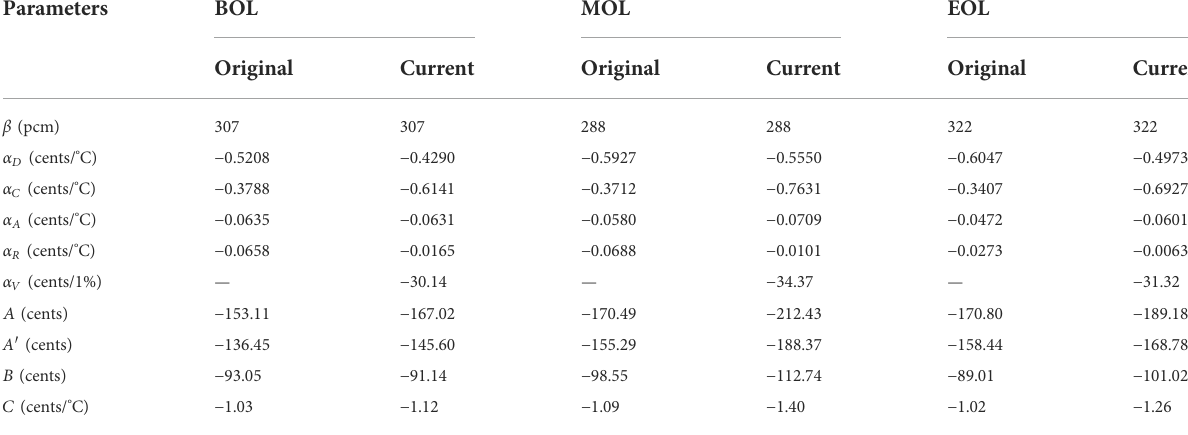
TABLE 3 Dynamic parameters of SPALLER under different life cycles.